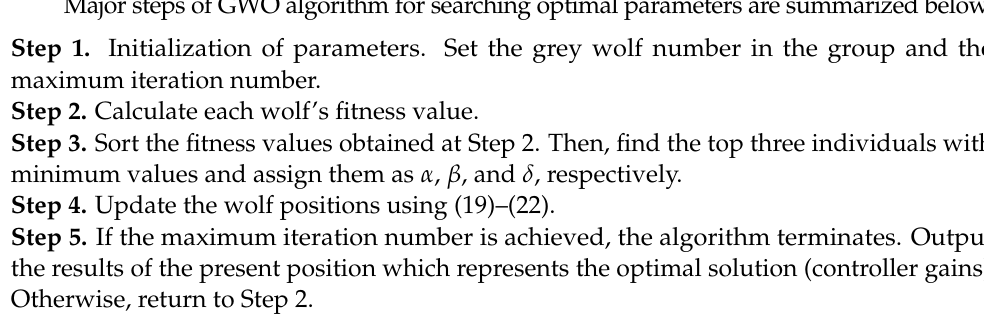
Figure 12. GWO search directions: ( a ) attacking prey; ( b ) searching for prey. Major steps of GWO algorithm for searching optimal parameters are summarized